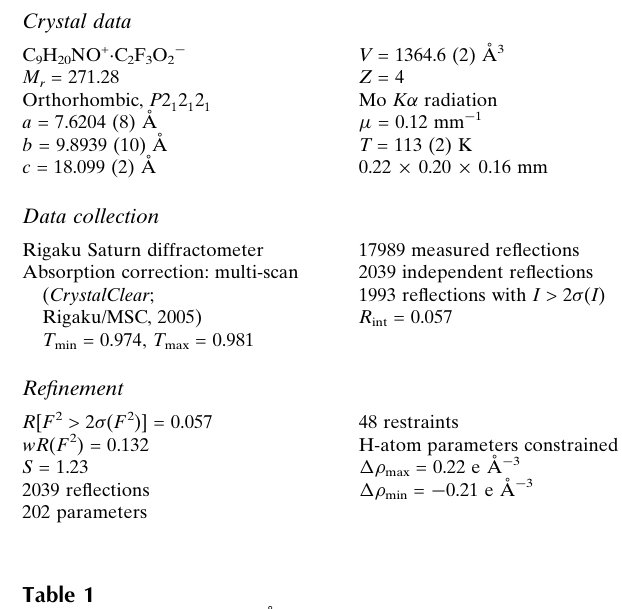
Hydrogen-bond geometry (A˚ , (cid:4)